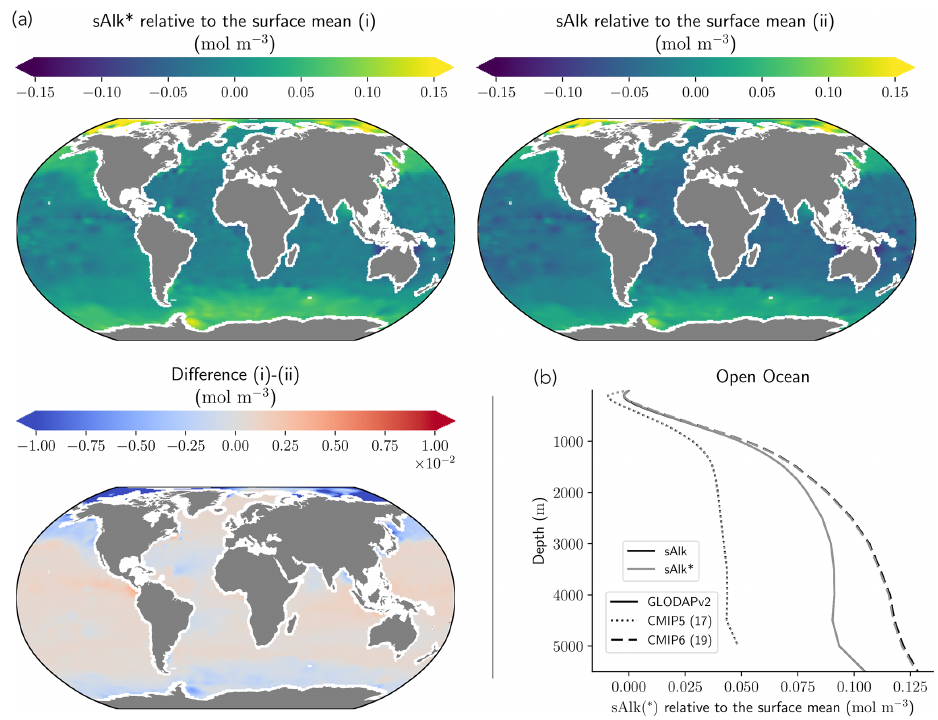
Figure B1. Evaluation of two different salinity normalization strategies. (a) Open-ocean surface sAlk ∗ and sAlk anomalies relative to the surface mean, and the difference. (b) Profiles of sAlk ∗ and sAlk for GLODAPv2 as well as CMIP5 and CMIP6 ensemble means. sAlk is defined in Sect. 2.4 and sAlk ∗ in Appendix